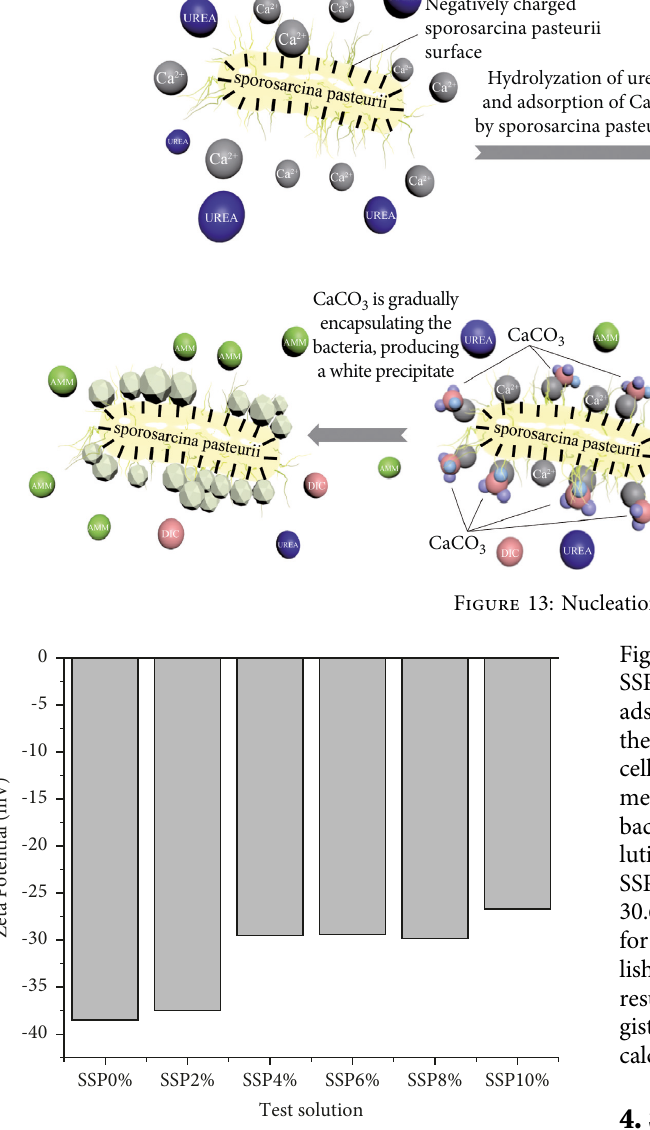
Figure 14: Solution potential Figure 10, the change in potential from SSP4–10% indicated